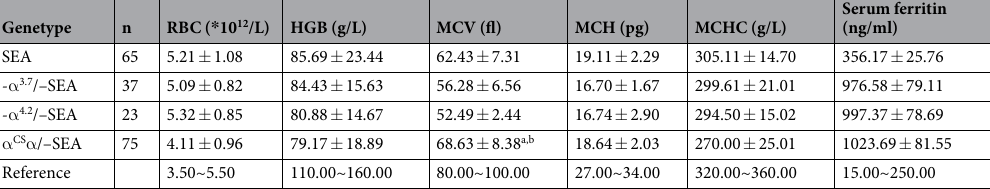
Table 1. Clinical Average Hematological Parameters of the Study Population ( ± x s ). RBC, red blood cell; HGB, haemoglobin; MCV, mean corpuscular volume; MCH, mean corpuscular haemoglobin; MCHC, mean corpuscular haemoglobin concentration; SEA: the Southeast Asian deletion; - α 3.7, rightward deletion; - α 4.2, leftward deletion; CS, Hb Constant Spring. a:compared with - α 4.2/–SEA, P < 0.001; b:compared with - α 3.7/– SEA, P < 0.001. Note : RBC, HGB, MCV, MCH and MCHC were the average hematological parameters level before the first blood